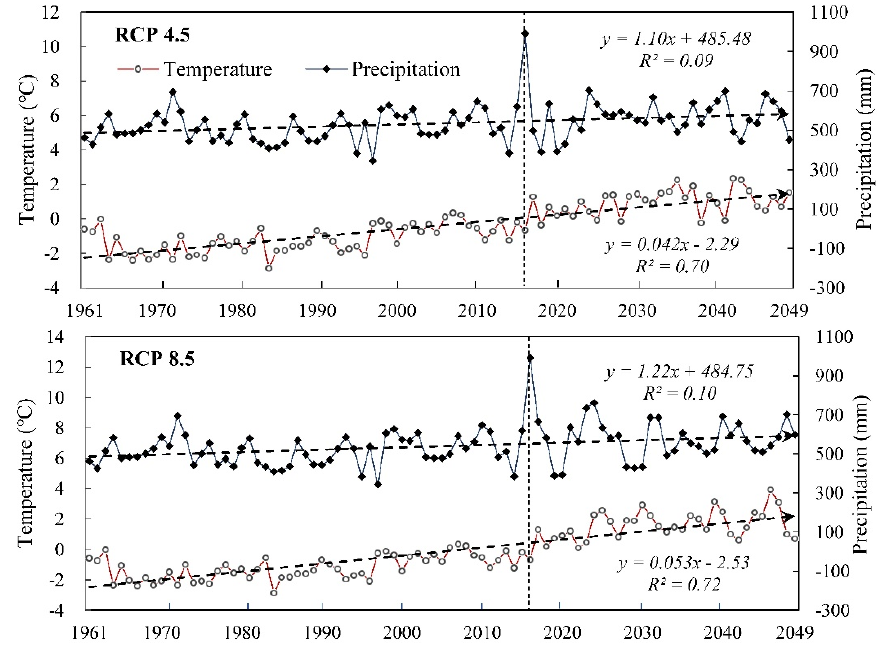
Figure 8. The change process of annual average temperature and annual total precipitation between the baseline (1961–2016) and the future period (2017–2049) for the Jinghe River Basin under the RCP4.5 and RCP8.5